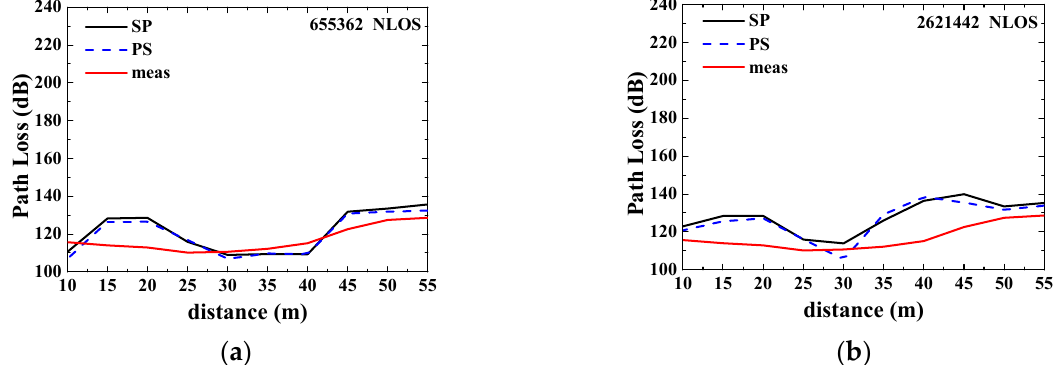
Figure 16. Path loss comparison of theoretical calculation with measured data for 655,362 and 2,621,442 rays in the NLOS. ( a ) The number of rays is 655,362 ( b ) The number of rays is 2,621,442. Table 4. The RMSE in the NLOS. RMSE